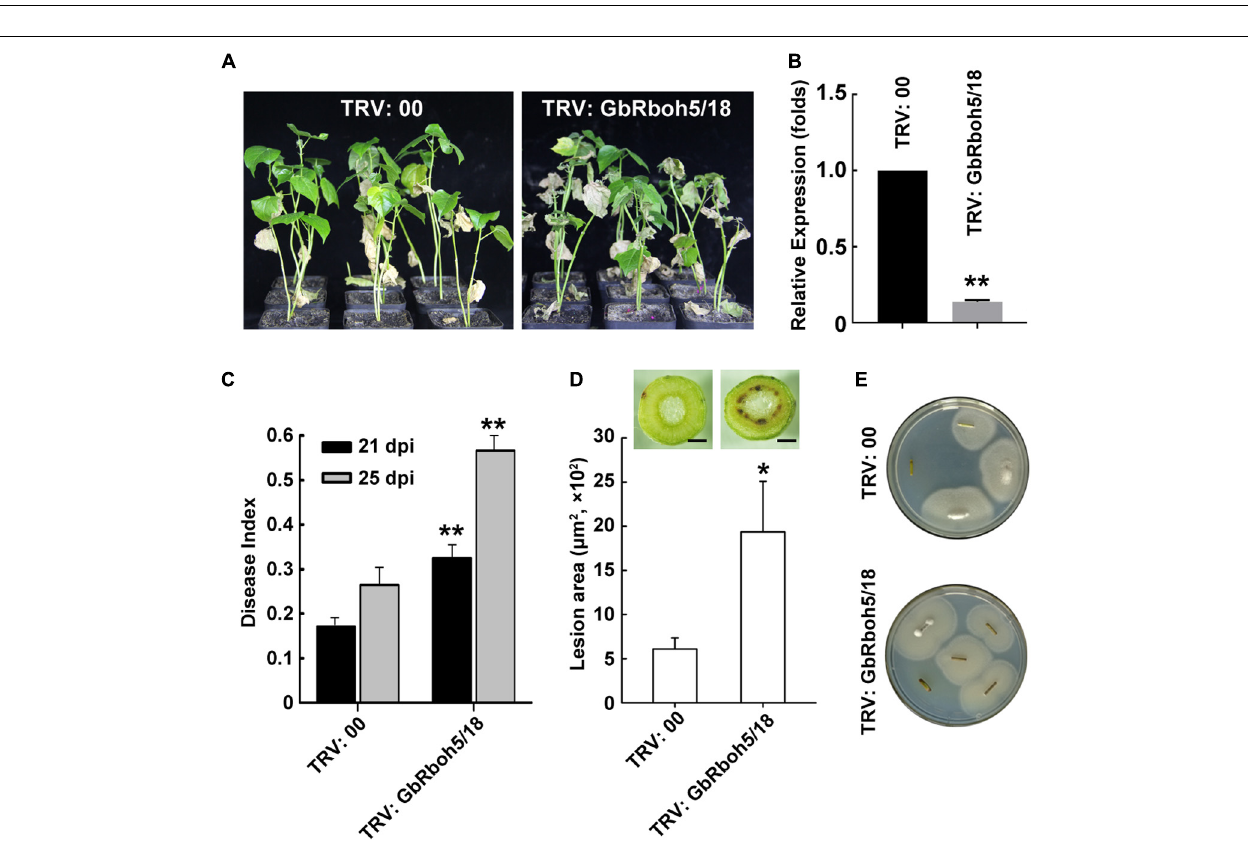
FIGURE 6 | Knock-down of GbRboh5/18 attenuates plant resistance to V. dahliae . (A) Disease phenotype of cotton plants (“Xinhai15”) at 25 days post-infection with V . dahliae strain Vd991. Seedlings were inoculated with V. dahliae two weeks after VIGS and photographed 25 days later. (B) Expression of GbRboh5/18 in GbRboh5/18-VIGS and control plants. UBQ7 was the internal reference gene (** p < 0.01; Student’s t -tests). (C) Disease index of GbRboh5/18 - VIGS and control plants at 21 and 25 dpi with V. dahliae . Asterisks indicate significant differences compared with TRV: 00 at same time (* p < 0.05; ** p < 0.01, Student’s t -test). (D) Lesion area of GbRboh5/18-VIGS and control plants’ stems at 25 dpi with V. dahliae . Transverse section of stems were photographed with an OLYMPUS CX31 microscope. The values are the mean ± SD, n ≥ 30. Bar = 0.5 mm. (E) Fungal recovery assay. Sterile stems approximately 1 cm from same position of plants was plated on PDA plates at 25 ◦ C to allow V. dahliae recovery; photographs were taken 3 days post-inoculation. All experiments were repeated at least three times, with similar results.